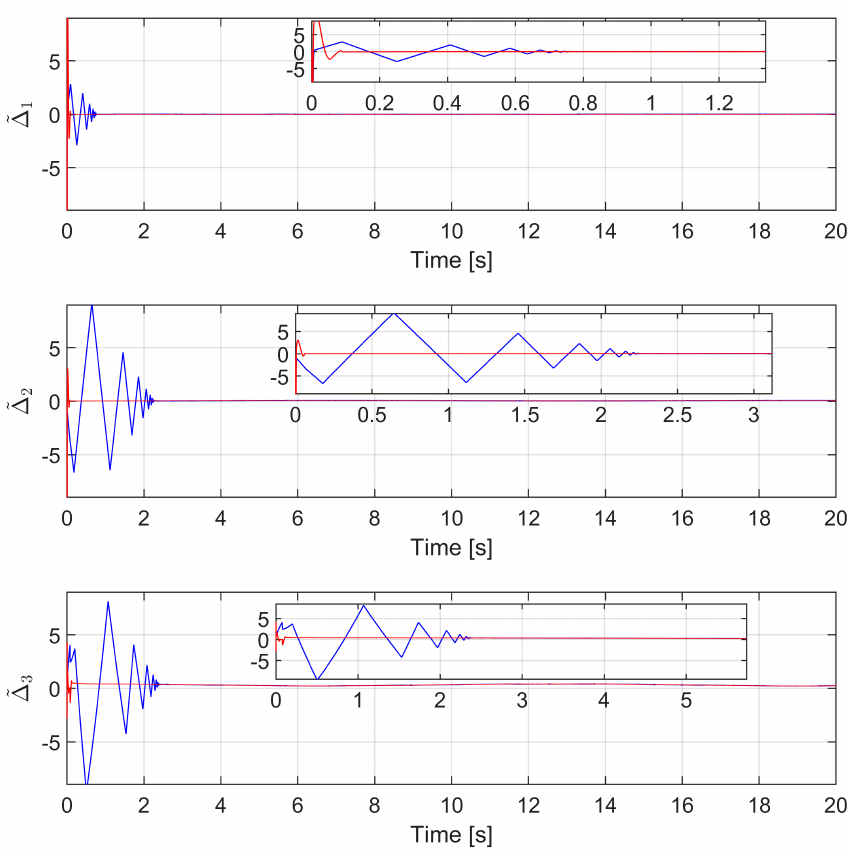
Figure 5. The comparison of the estimated errors between the FnTDO and the proposed FxTDO.